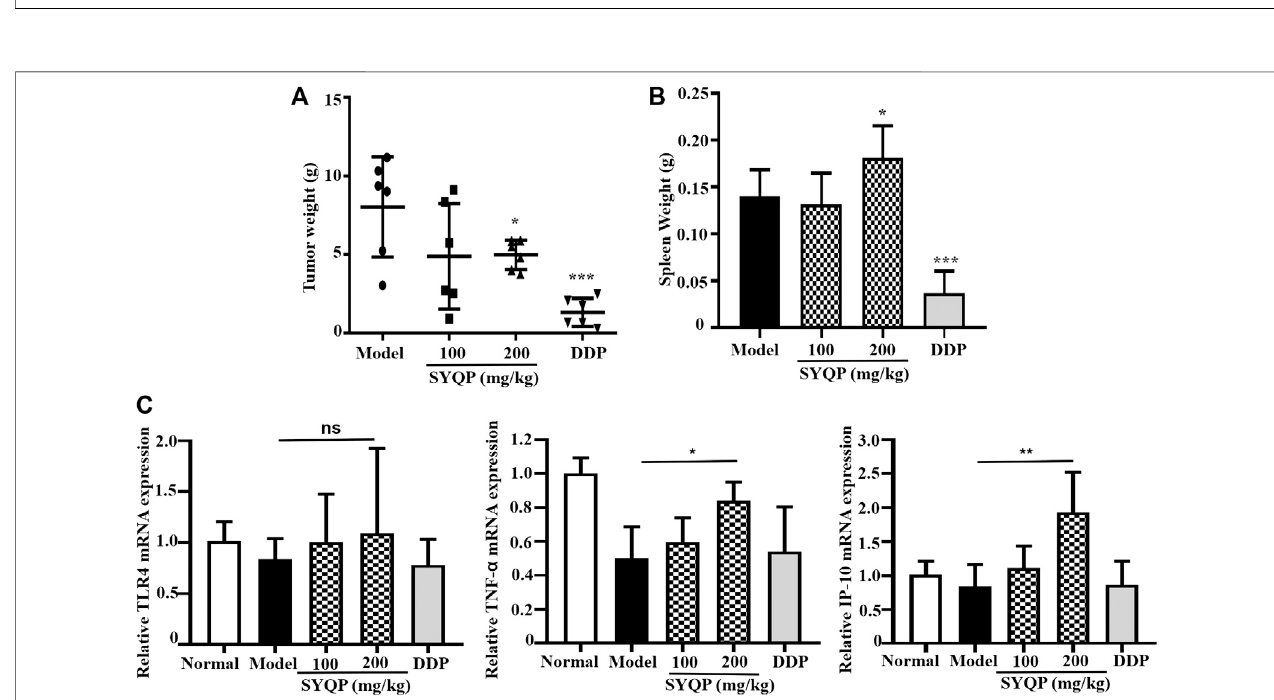
FIGURE 7 | SYQP reduced tumor burden and enhanced spleen weight of LLC-bearing mice. C57BL/6 mice ( n (cid:2) 6) were injected s.c. with LLC tumor cell lines. Once palpable tumors were formed (day 7), mice were orally administered with SYQP (100, 200 mg/kg) or PBS (control) for seven consecutive days. DDP at 2 mg/kg was intraperitoneally injected once every other day and set as a positive control. On day 15, mice were killed, and tumor tissues and spleen were excised and weighed. (A) SYQPadministrationreducedthetumorburdenofLLC-bearingmice. (B) SYQPadministrationincreasedthespleenweightofLLC-bearingmice. (C) Theeffect of SYQP on the mRNA expression of TLR4, TNF- α , and IP-10 in the spleen tissue. * p < 0.05, *** p < 0.001 vs. control.